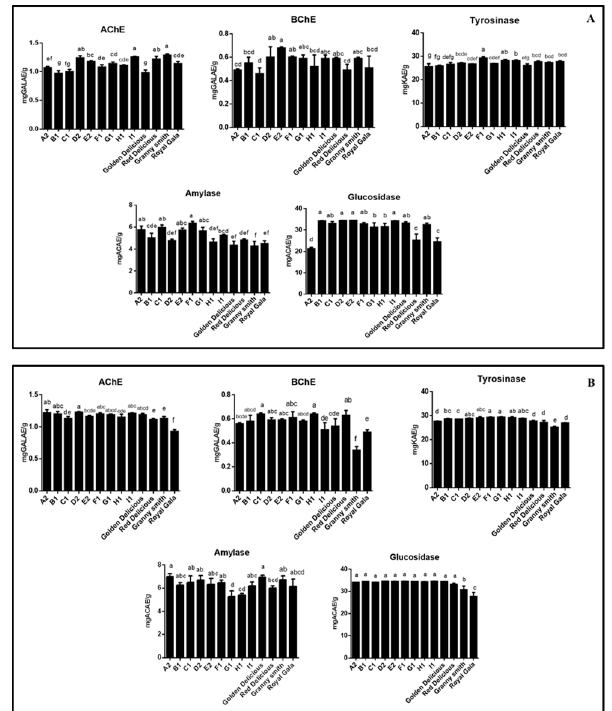
Figure 8. Enzyme inhibitory properties of tested Pulp extracts ( A ) and Peel extracts ( B ). Values expressed are means ± S.D. of three parallel measurements. GALAE: Galatamine equivalent; KAE: Kojic acid equivalent; ACAE: Acarbose equivalent. Different letters indicated significant differences in each group (pulp or peels) ( p < 0.05).